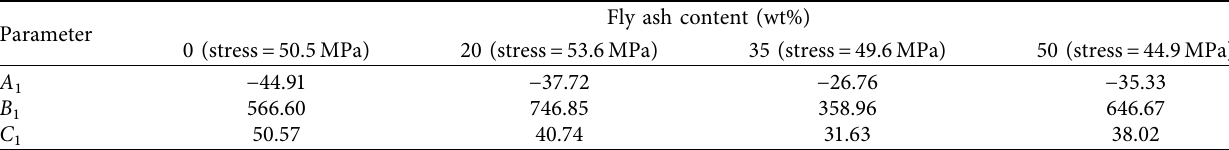
Table 5: Fitting parameters of concrete with various fly ash replacement ratios during the decelerating/isokinetic creep stage.